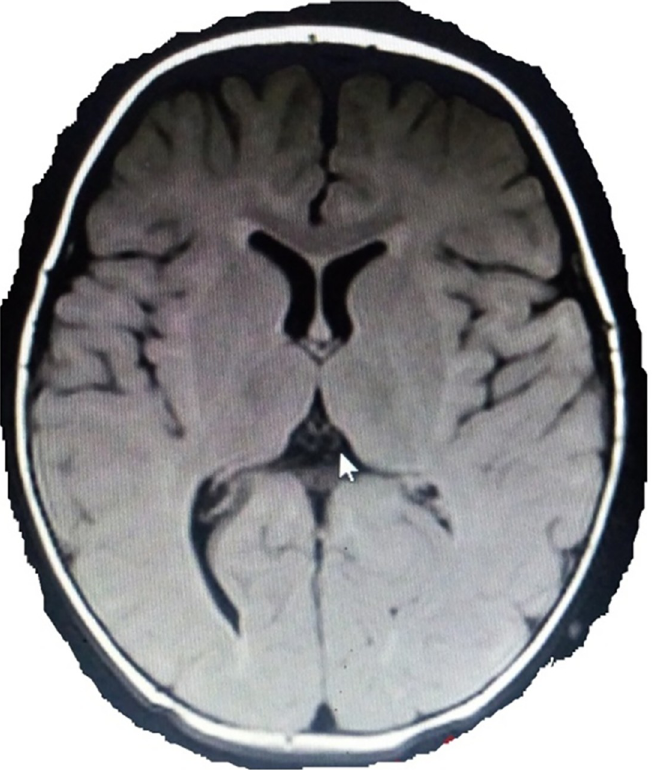
Fig 3. MRI of an 11 month old patient with spastic diplegia. MRI of an 11 month old male patient born at term with spastic diplegia (Case 31 ) showing deep right occipital horn posteriorly with temporal/frontal minimal increment in CSF spaces including cisterns (T2